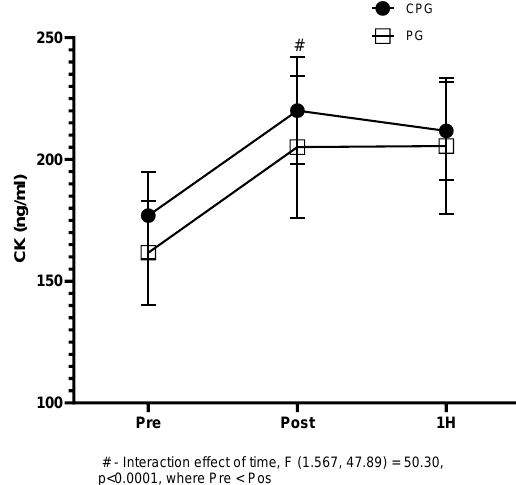
Figure 3. Graphs representing the leukocyte count across time: pre, post, and 1 h after performing the experimental running protocol. ( a ) Total leukocytes; ( b ) neutrophils; ( c ) monocytes; ( d ) lymphocytes. Values represented by the mean ± SD, (#) interaction (effect time), (&) interaction (time × treatment).